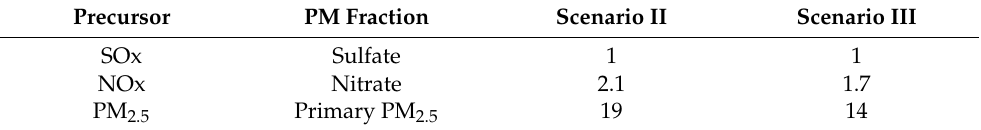
Table 2. Relative contributions of precursor emission reductions of the simulated PM 2.5